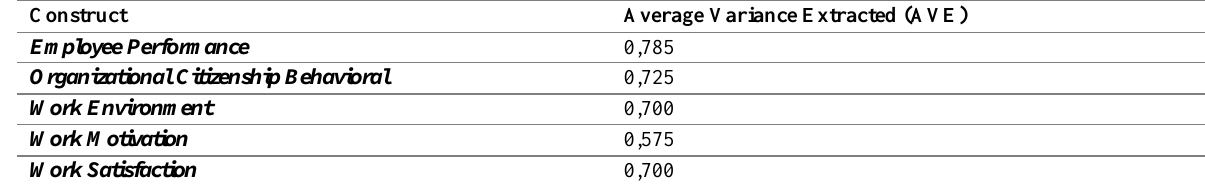
Table 2: Average Variance Extracted